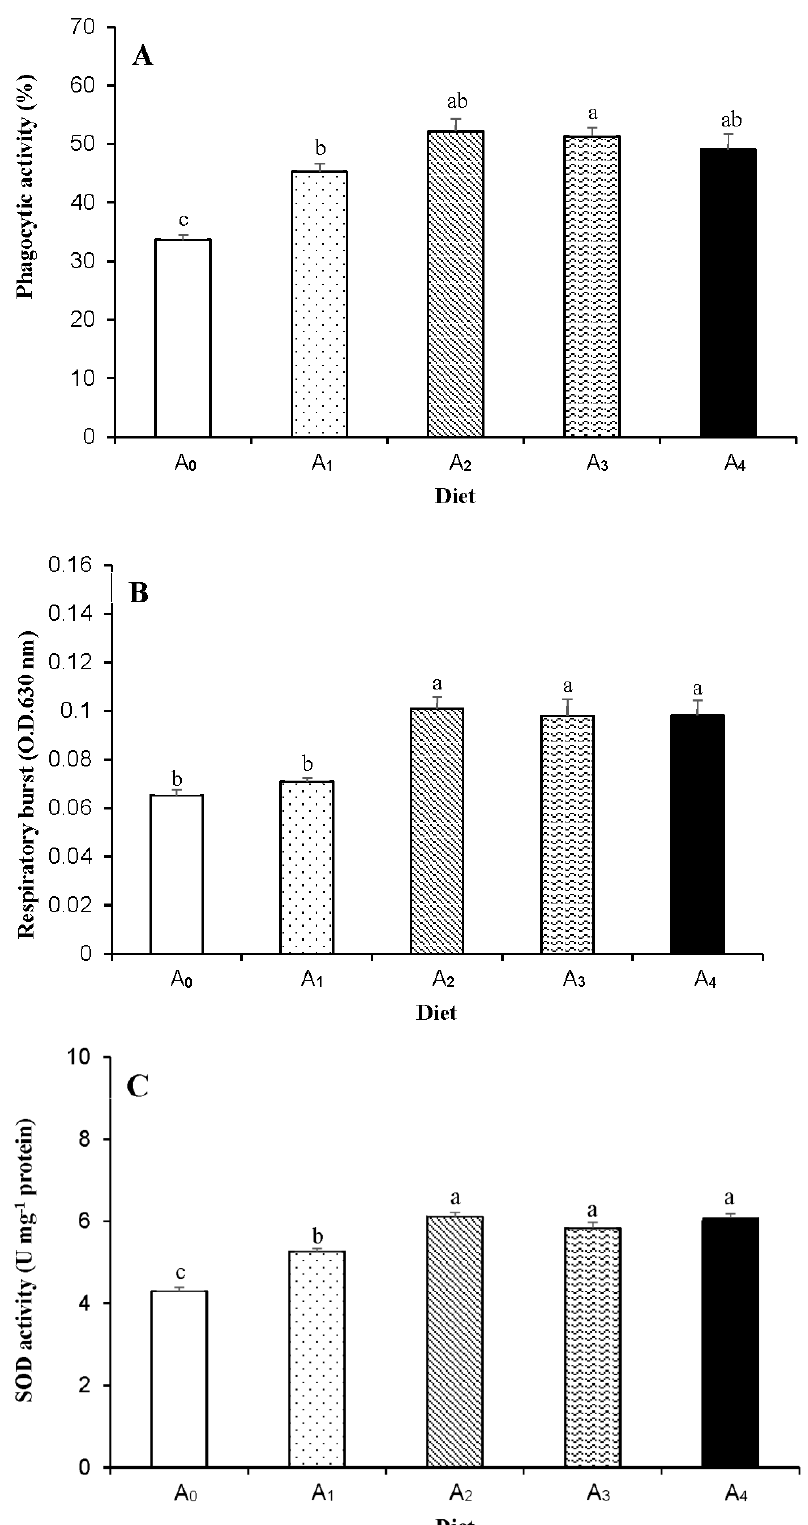
Figure 2. The innate cellular parameters of phagocytic activity ( A ), respiratory burst ( B ), and SOD activity ( C ) measured in E. coioides fed diets supplemented with Antrodia camphorata (AC) at 0 (A 0 ), 1.5 (A 1 ), 3.0 (A 2 ), 4.5 (A 3 ), and 6.0 (A 4 ) g kg −1 after 28 days of supplementation. SOD, superoxide dismutase. Each bar represents the mean value from 6 replicates (15 fish in each replicate) with the standard error. Data with different lowercase letters significantly differ ( p < 0.05) among treatments.